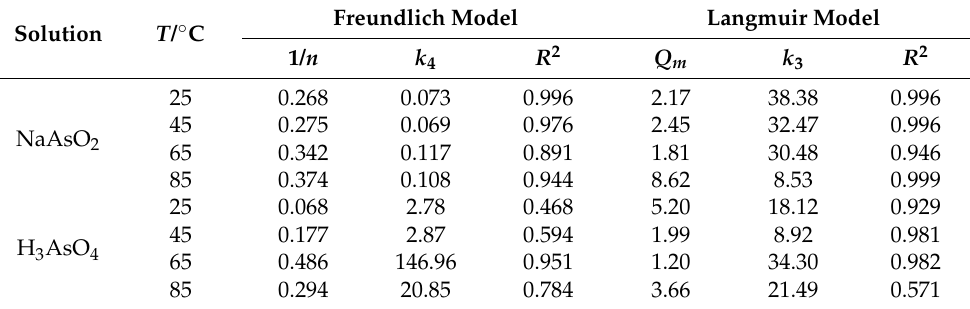
Table 5. Isothermal sorption parameters of iowaite.